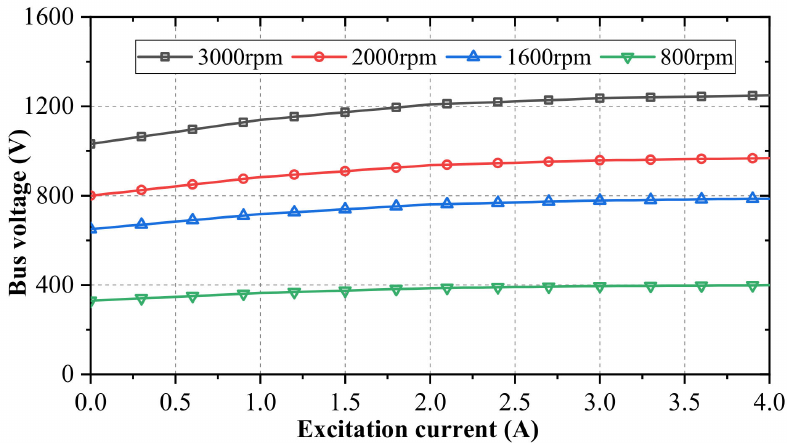
Figure 14. No-load voltage at different